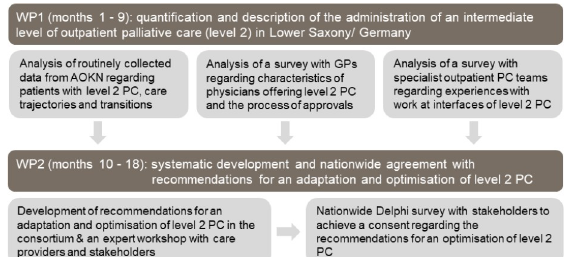
Fig 1. Mixed-methods study design. AOKN = statutory health insurance provider in Lower Saxony; GPs = general practitioners; PC = palliative care; WP = work package.